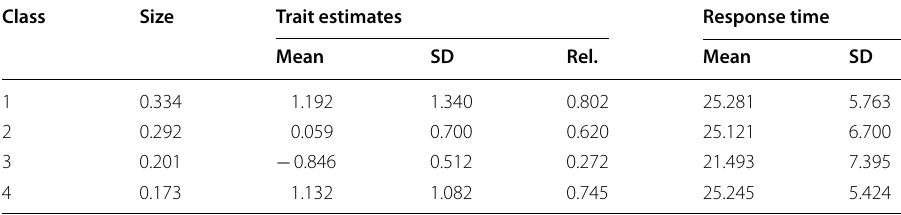
Table 2 Descriptive statistics and internal consistency reliability for person estimates in four-class